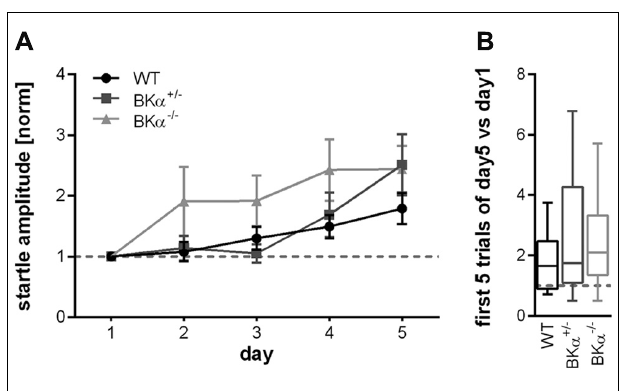
see Materials and Methods” for detailed description). Data is displayed as median in a box–whisker plot, with whiskers indicating the 5th and 95th percentile. * p = 0.009. (C) The baseline startle response was significant lower in knock-out animals than in WT. Data is displayed as median with whiskers indicating the 5th and 95th percentile. 18 WT (10 males/8 females), 17 BK α + / − (10/7), and 19 BK α − / − mice (9/10) were tested. *** p = 0.001.